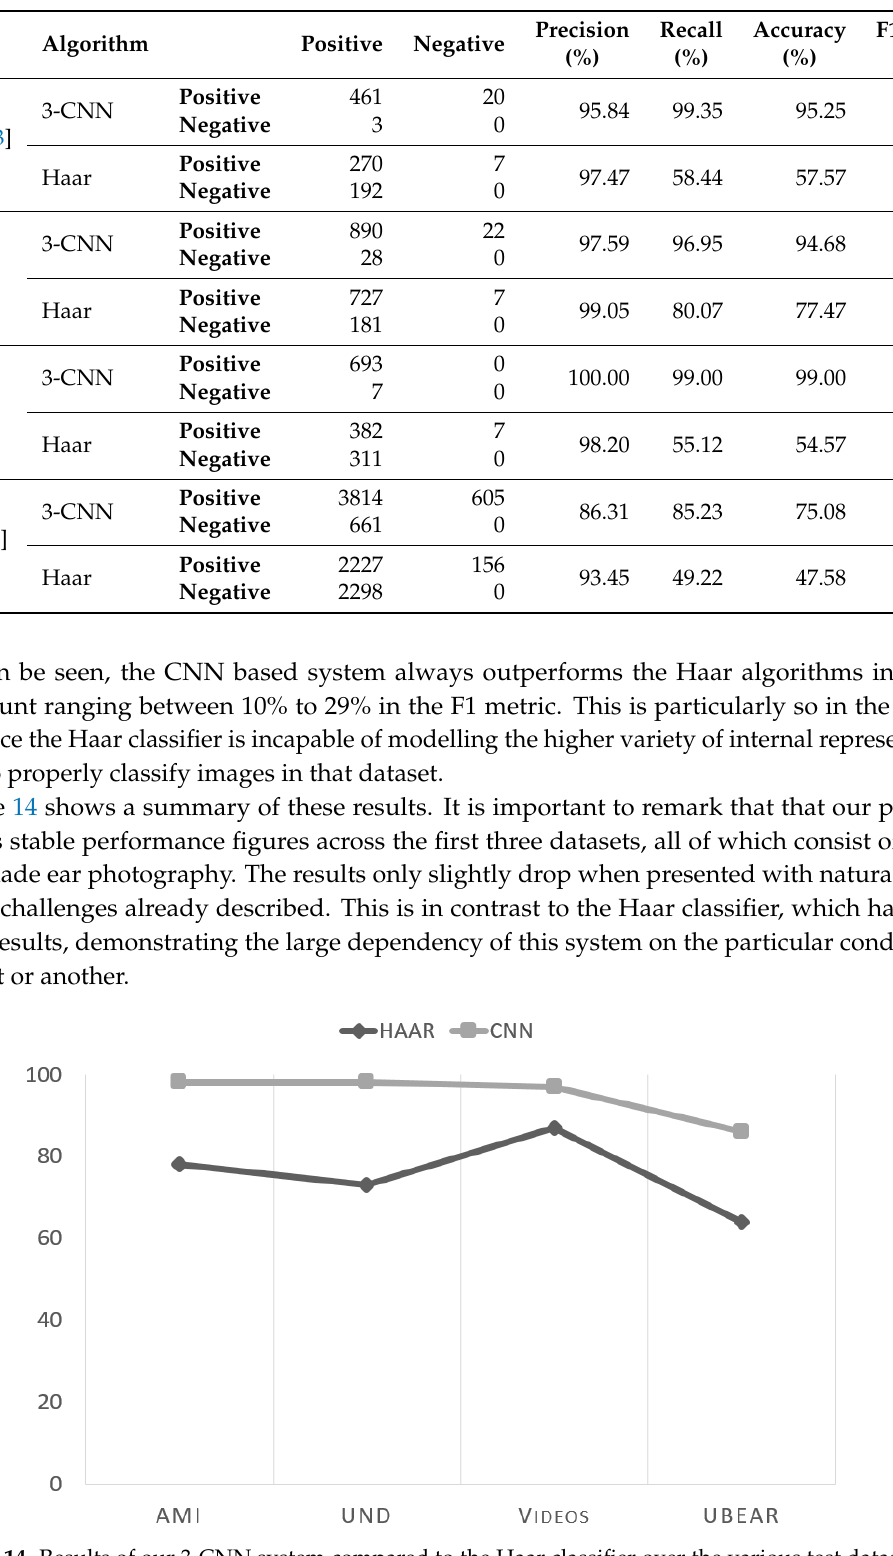
Figure 14. Results of our 3-CNN system compared to the Haar classifier over the various test